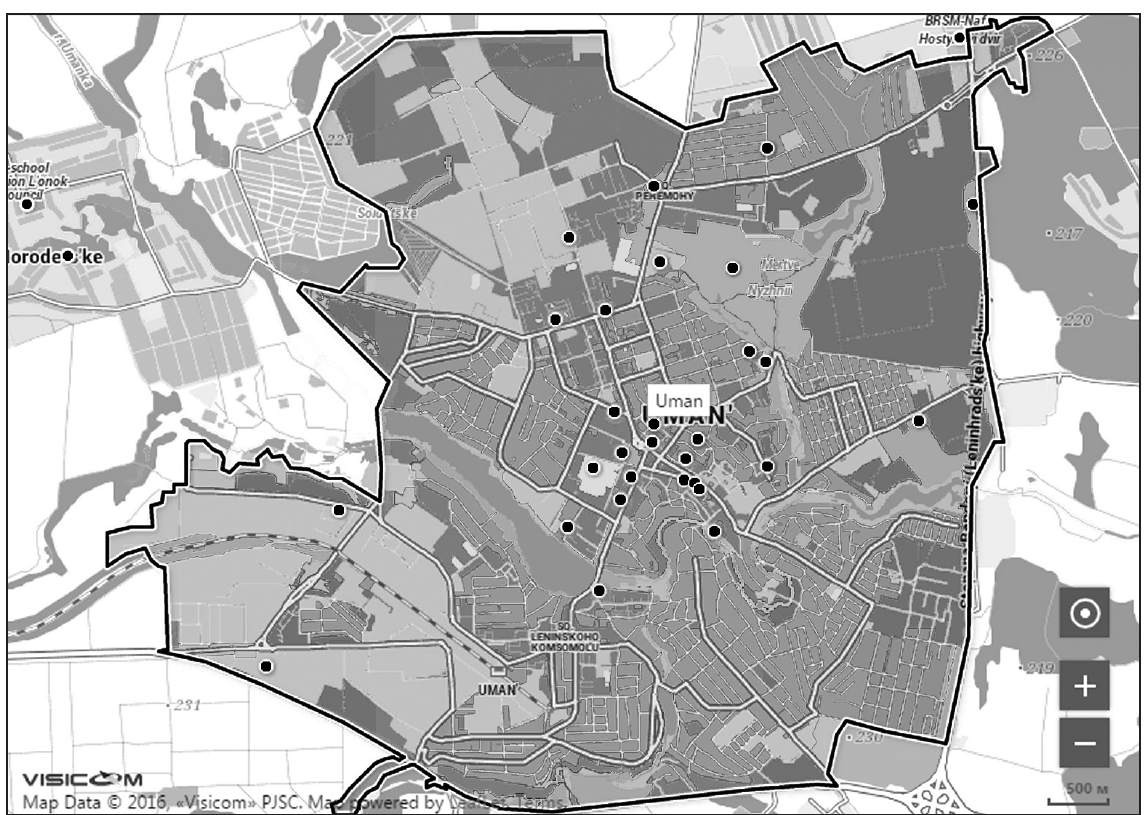
Figure 3. The schematic map of locating objects of trade, public catering and consumer services in